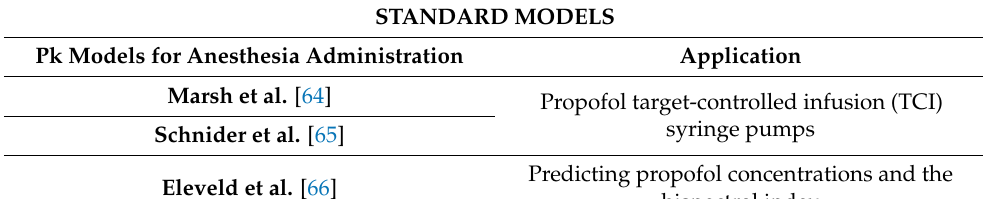
Table 1. The potential opportunities from in silico studies and Pk/PD